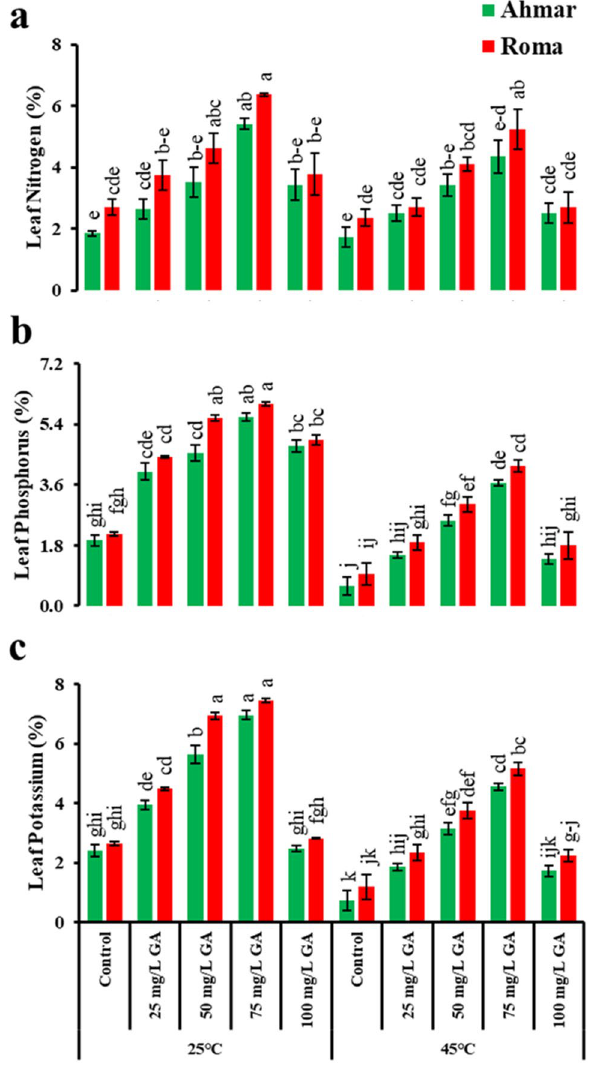
Figure 3. Leaf minerals concentration of tomato as affected by temperature, genotype and exogenous application of GA 3 . According to Tukey’s honestly significant difference test, the same letters suggest that there is no statistically significant difference between treatments ( p ≤ 0.05). Vertical bars indicate average ± standard error (n = 4, 5 plants per